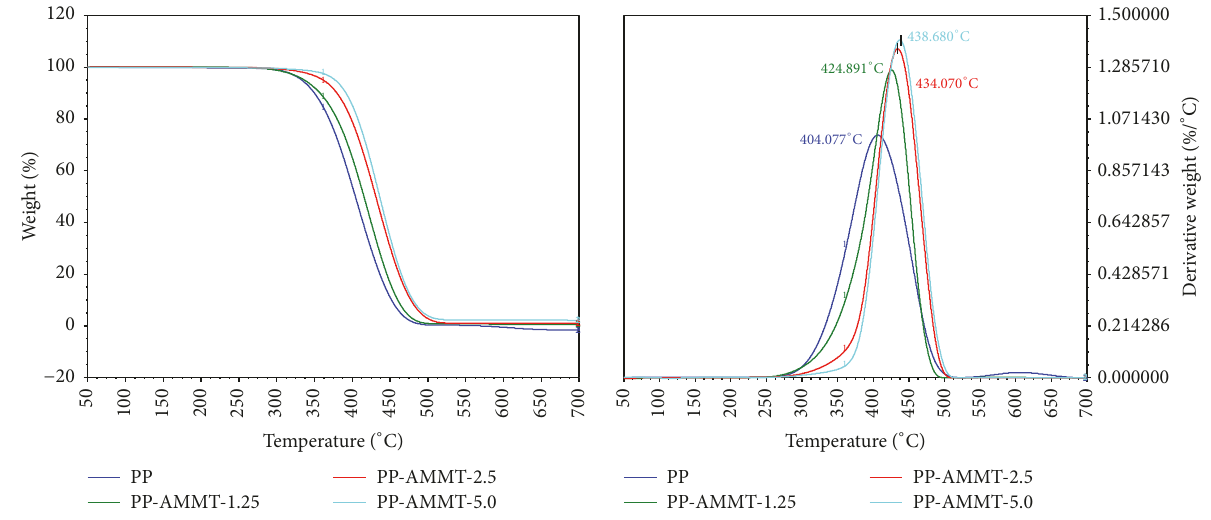
Figure 4: TGA trace and derivative curves of PP-AMMT composites.